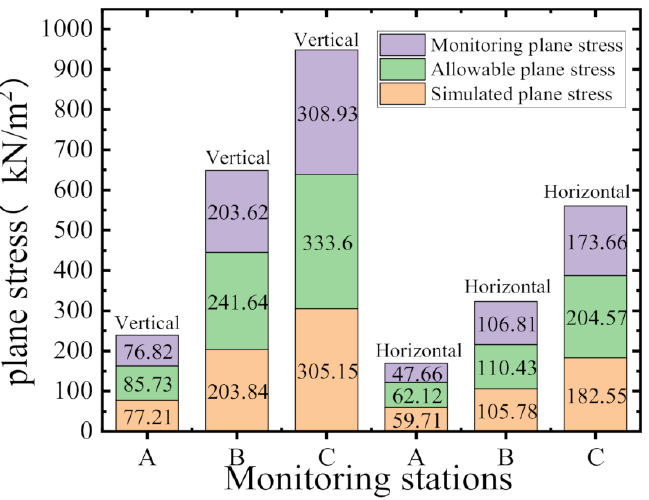
Figure 14. Vertical and horizontal plane